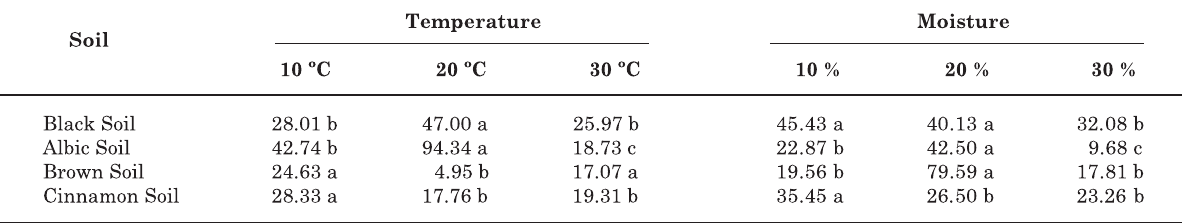
Table 1. V / K of soil β -glucosidase under different environmental temperature and moisture regimes max m